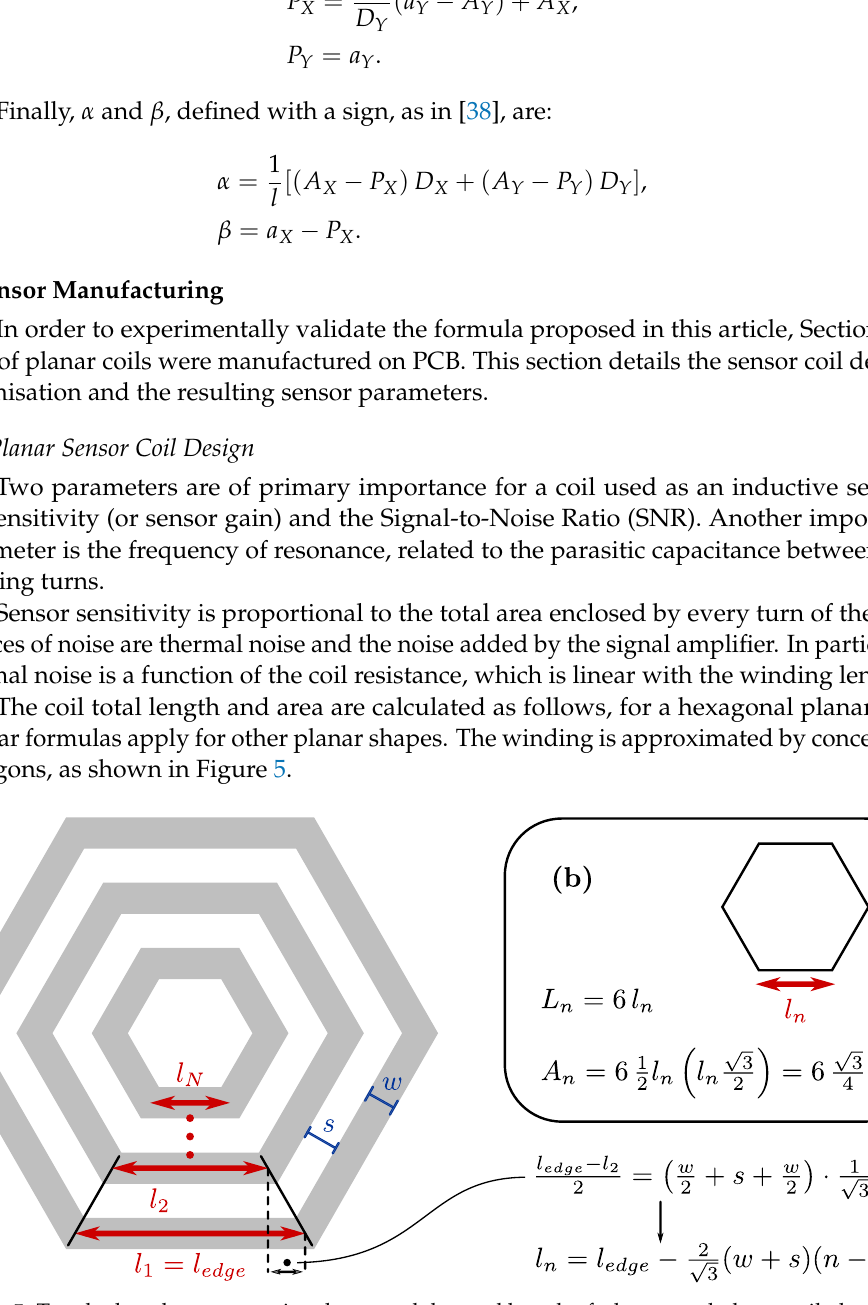
Figure 5. To calculate the cross-sectional area and the total length of a hexagonal planar coil, the spiral is approximated as a set of concentric hexagons. ( a ) The edge length, l n , of the n th inner turn depends on the external edge, l edge , and the trace width, w , and spacing, s . In the box ( b ), formulae for the equilateral hexagon perimeter L n and area A n